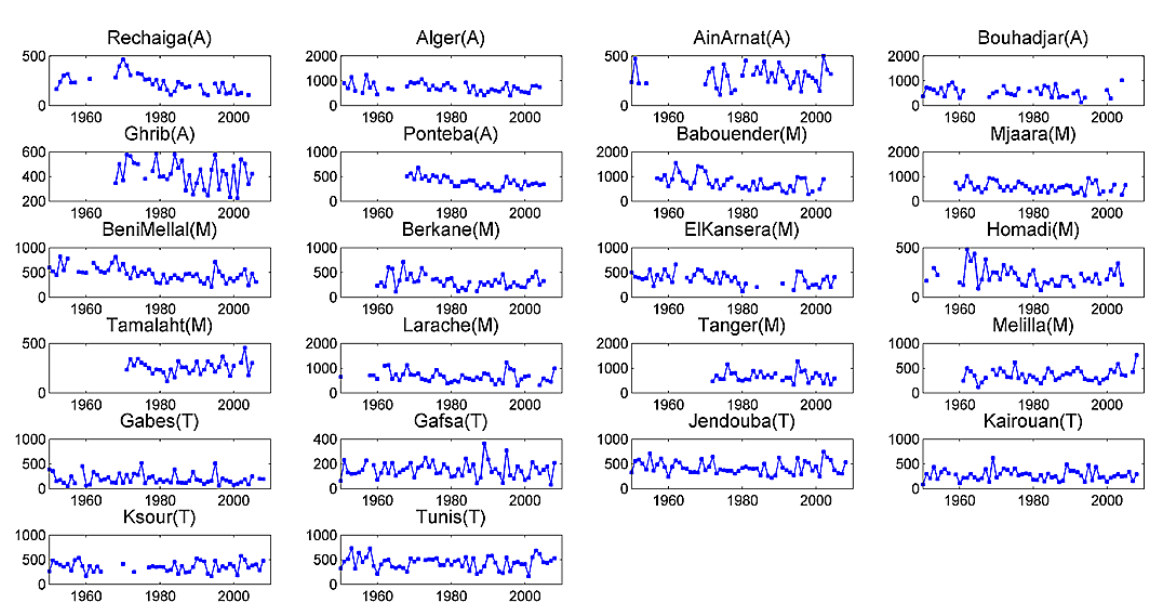
Fig. 7. Times series of the annual total precipitation (PRCPTOT, in mm) at the different